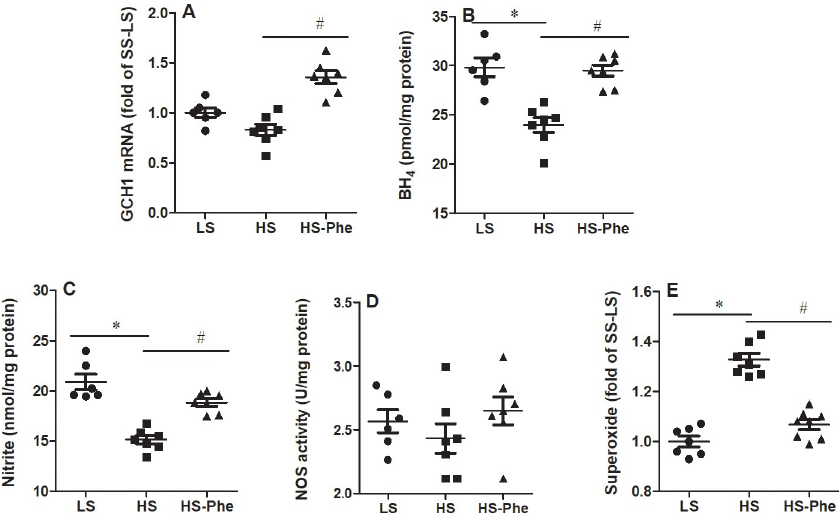
Fig 4. Effects of phenylalanine on GCH1 mRNA (A), BH4 (B), nitrite (C), NOS activity (D), and ROS (E) in the kidneys of Dahl SS rats fed a low salt or high salt diet. Each value represents the mean ± SEM, n = 6–8, � p < 0.05 vs. LS group, # p < 0.05 vs. HS